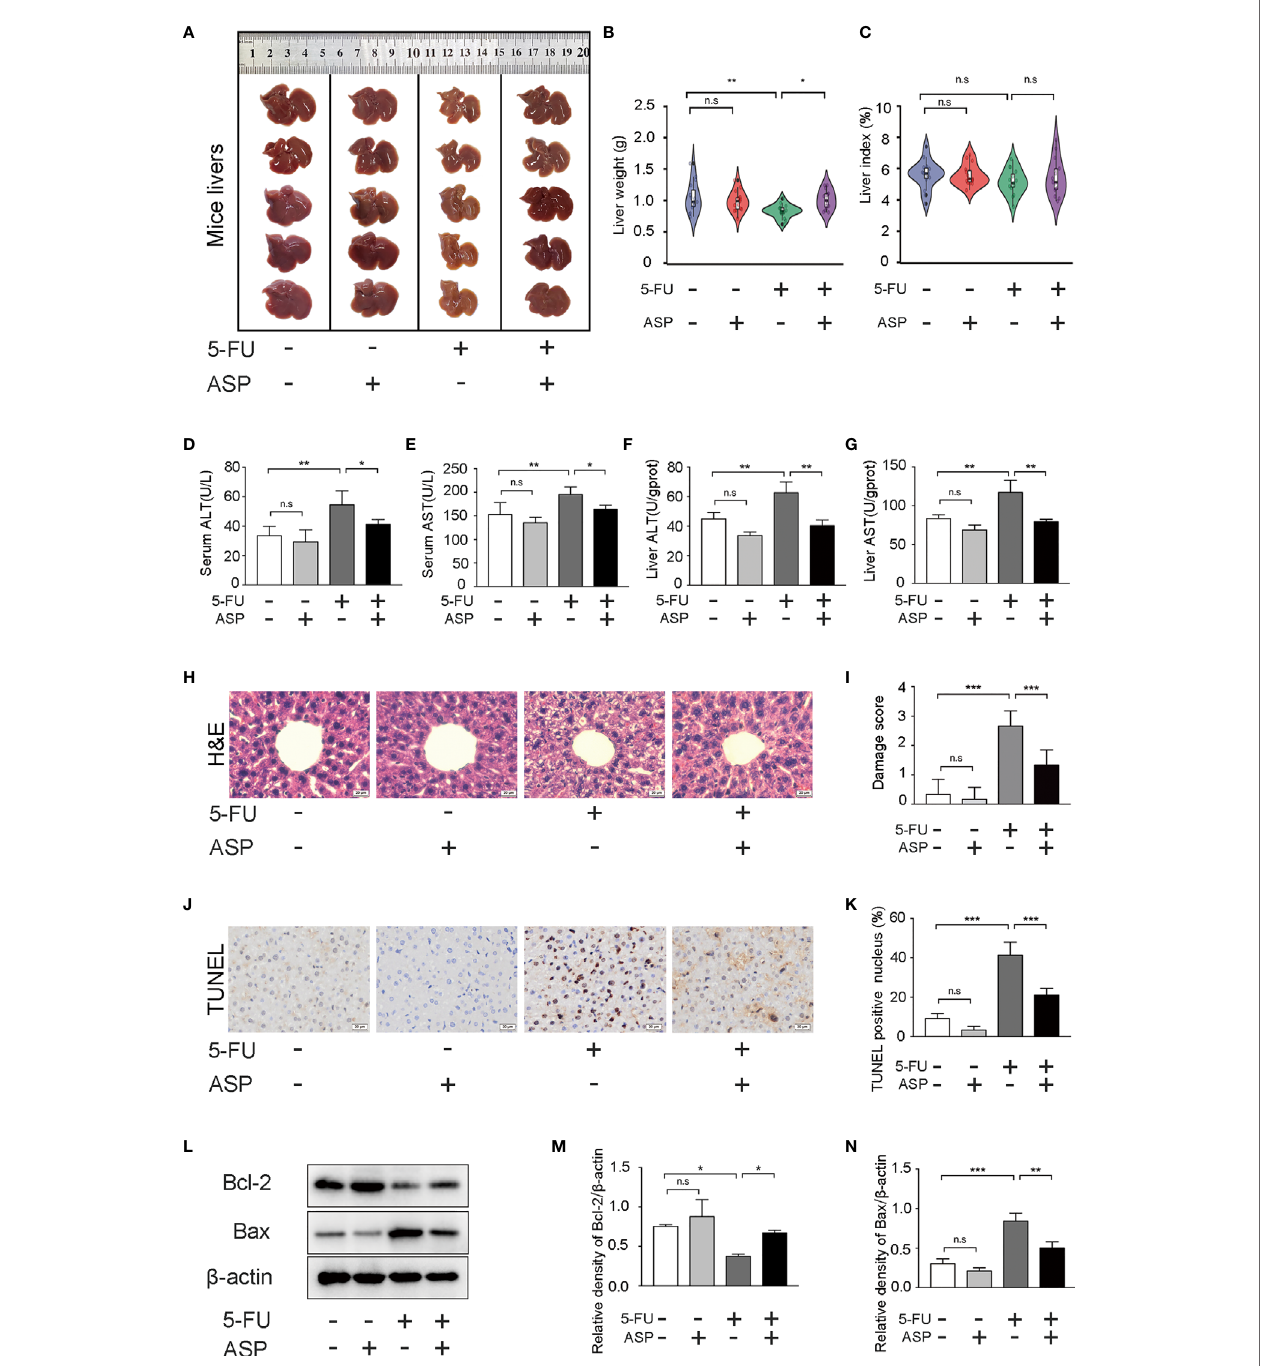
FIGURE 1 | ASP attenuated 5-FU-induced liver histopathological damage and apoptosis in mice. (A) The appearance of the livers of each group was examined. (B) The weight of livers of each group was examined ( n = 15/group). (C) The liver index was calculated by the ratio of the liver weight (g) to the mouse body weight (g) x 100 ( n = 15/group). (D, E) The levels of ALT and AST in serum were detected ( n = 5/group). (F, G) The levels of ALT and AST in mice liver were detected ( n = 3/group). (H, I) Hematoxylin and eosin staining (magni fi cation, × 400, scale bar, 20 m m). The stained sections were scored using a four-point scale from 0 to 3, with 0, 1, 2, and 3 representing no damage, mild damage, moderate damage, and severe damage, respectively ( n = 6/group). (J, K) TUNEL staining and quantitative results of the percentage of TUNEL-positive cells in the liver of different experimental groups (magni fi cation, × 400, scale bar, 20 m m). Images were analyzed using the image analysis program ImageJ ( n = 6/group). (L – N) Western blot assay was performed to detect the levels of Bcl-2 and Bax. The intensity of the bands was calculated using ImageJ software. b -actin served as the internal control ( n = 3/group). * p < 0.05; ** p < 0.01; *** p < 0.001. n.s., not statistically signi fi